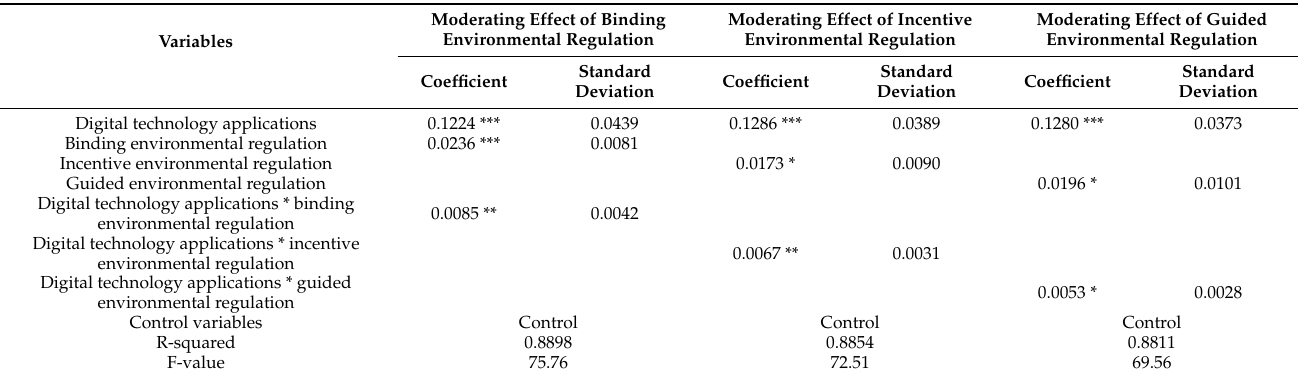
Table 10. Test of the moderating effect of environmental